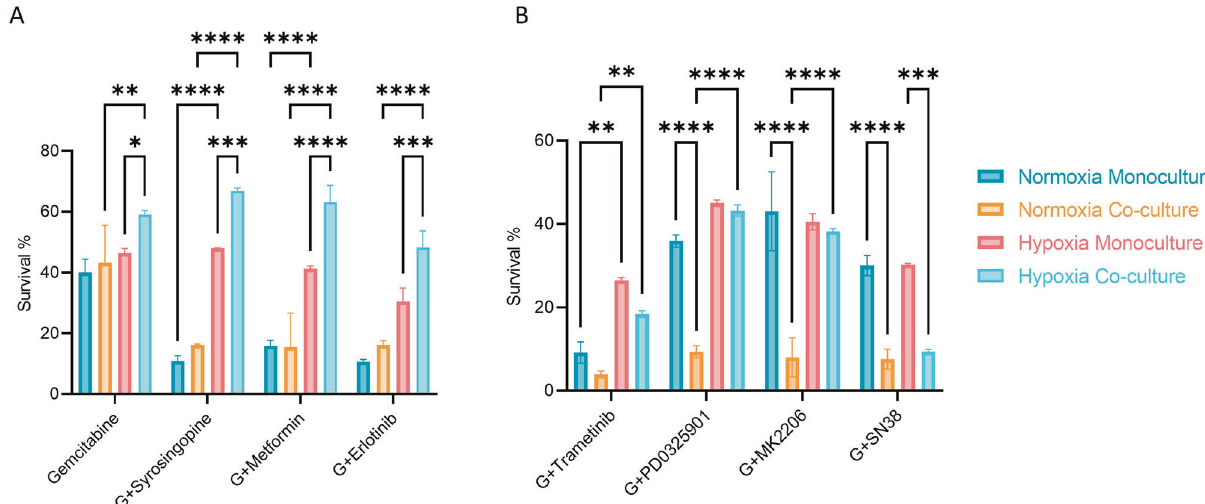
Fig. 4 Chemotherapy treatment effect under different oxygen tension. PDAC organoids were grown in monoculture and co-culture with PSCs under normoxia and hypoxic conditions. The cells were grown for 4 days on the OrganoPlate ® and subjected to several combinations of (chemo)therapeutics for 72 h, after which their survival was analyzed with Cell Titer Glo 3D viability assay. The graphs show the survival of the cultures normalized to a no-treatment control (medium only). Cells were subject to 1 µM Gemcitabine (G) alone and in combination with other compounds (shown in graphs A and B ). Shown are mean + − SD and the data points represent individual chips ( N = 3, n = 3). Statistical analysis shows results of a 2-way ANOVA with Tukey ’ s multiple comparisons (**** p ≤ 0.0001, *** P ≤ 0.001, ** P ≤ 0.01, * P ≤